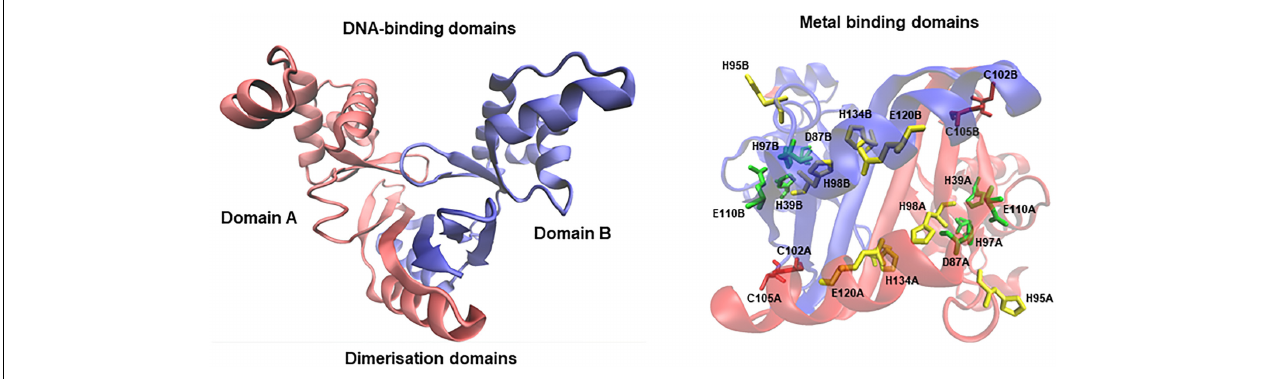
FIGURE 1 | Homology model of Fur from E. faecalis . Red and blue chains structures denote domain A and B, respectively. Each domain includes from residues 10 to 142. The stereo view represents the three putative zinc/iron binding domains (conserve residues in red, green, and